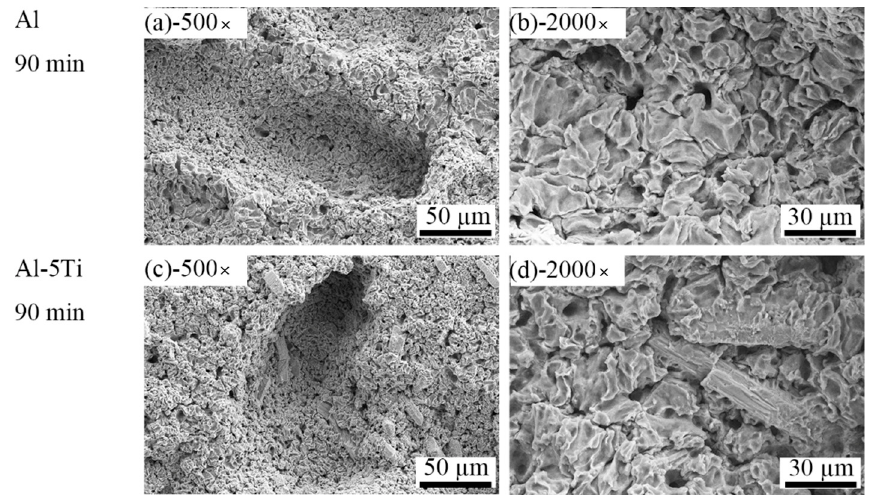
Figure 7. SEM images of different magnification of Al and Al-5Ti alloys after cavitation erosion for 90 min ( a ) 500 × of Al, ( b ) 2000 × of Al, ( c ) 500 × of Al-5Ti, ( d ) 2000 × of Al-5Ti.